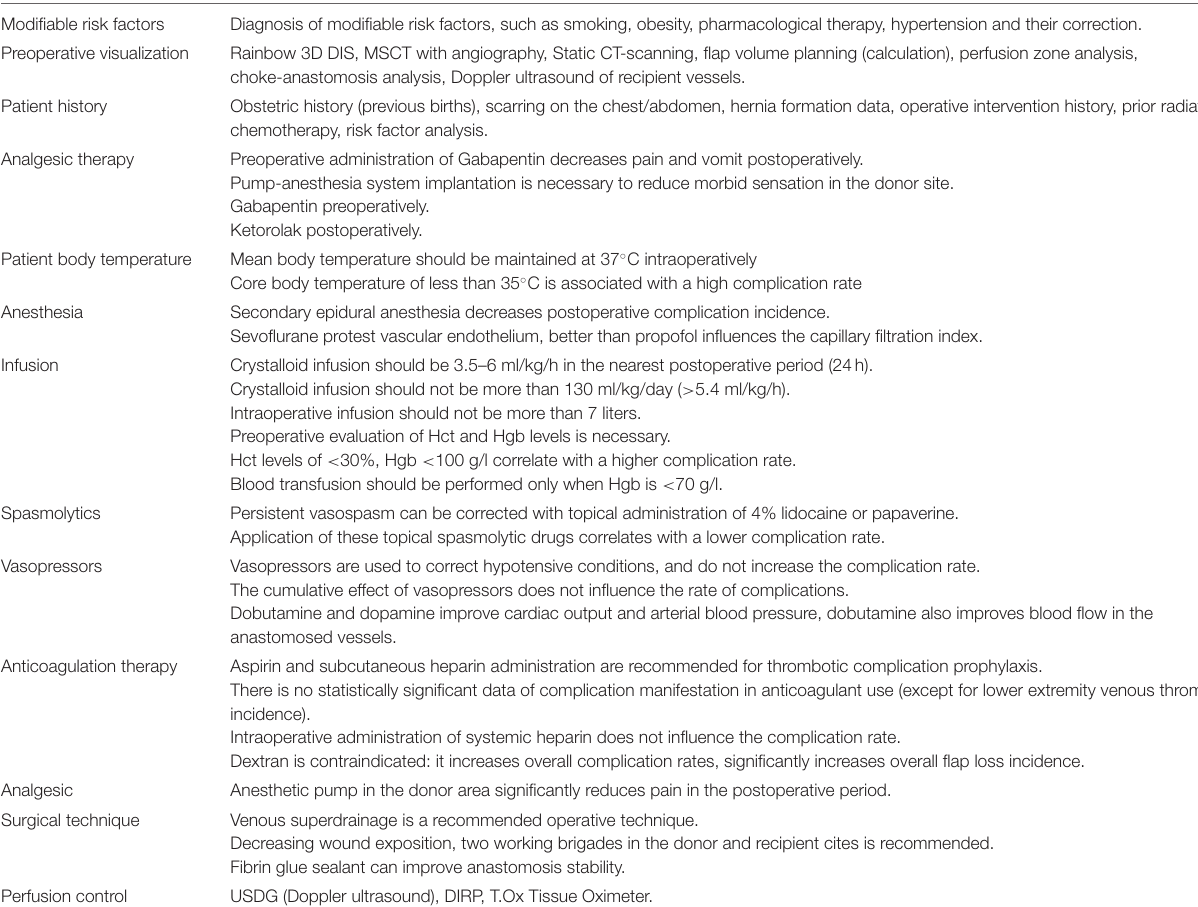
TABLE 1 | The patient management strategies in preoperative, intraoperaitve, and postoperative periods in order to minimize different complications observed in the DIEP flap-based breast reconstruction. Modifiable risk